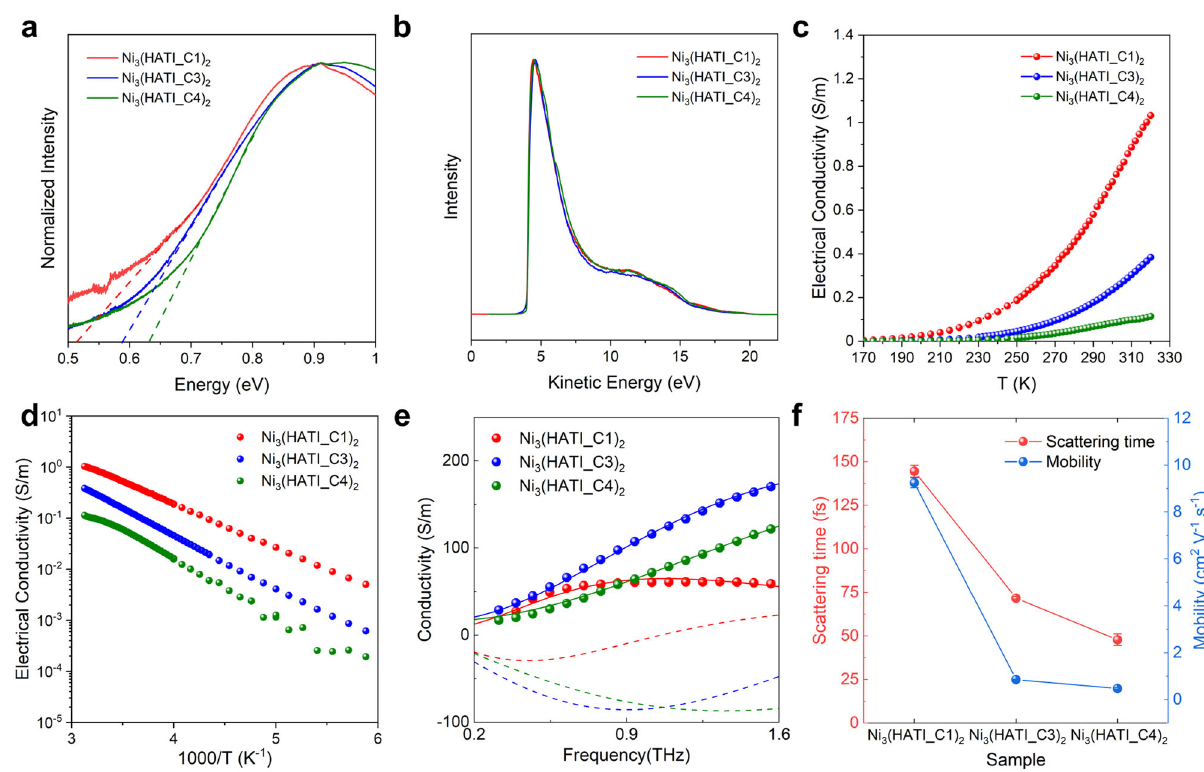
Fig.3|Optoelectronicandchargetransportpropertiesof2Dc-MOFs.a Vis − NIR absorption spectroscopy of Ni 3 (HATI_CX) 2 ; b UPS results of Ni 3 (HATI_CX) 2 , the abscissa axis is kinetic energy; c , d variable-temperature electrical conductivities